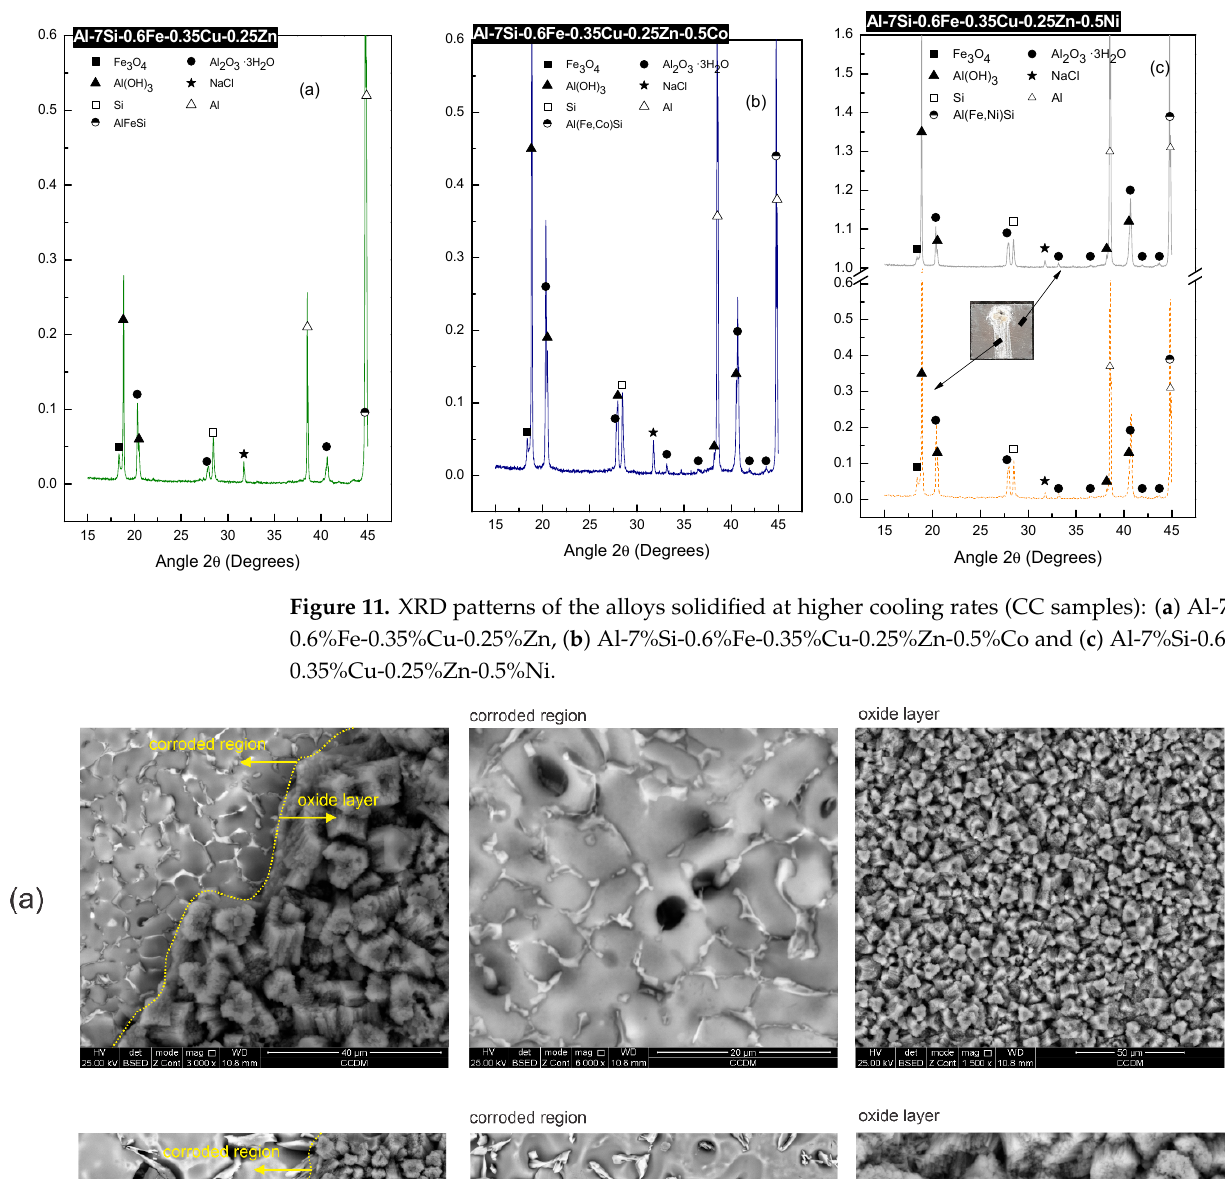
Figure 13. EDS measurements related to the inner and outer oxide layers formed during 30-day immersion experiments of the CC Al-7%Si-0.6%Fe-0.35%Cu-0.25%Zn-0.5%Ni alloy. 4. Conclusions In this study, the microstructure formation and corrosion behavior of as-cast Co and Ni containing Al-Si-based alloys were investigated, and the following findings were reached: • The microstructures of the alloys were formed by the α -Al dendritic matrix, Si and AlFeSi/AlFeSi(Ni)/AlFeSi(Co) phases. The additions of either Co or Ni were not able